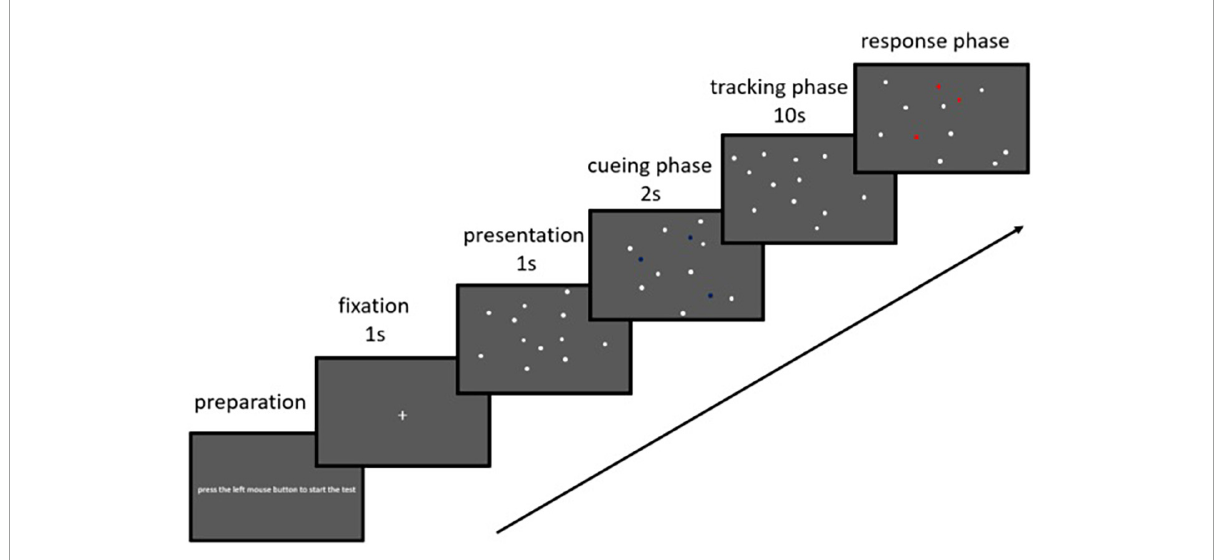
FIGURE1 A schematic diagram of the visual stimuli in one trial of the multiple object tracking task. Twelve filled white circles are presented. In each trial, three of the circles turn blue and flicker for 2 s before turning back to white. The blue flickering circles indicate the targets for that trial. All 12 circles then move 10 ◦ /s for a 10-s tracking period. When the circles stop moving, the participants use a mouse to click over their choices for the target